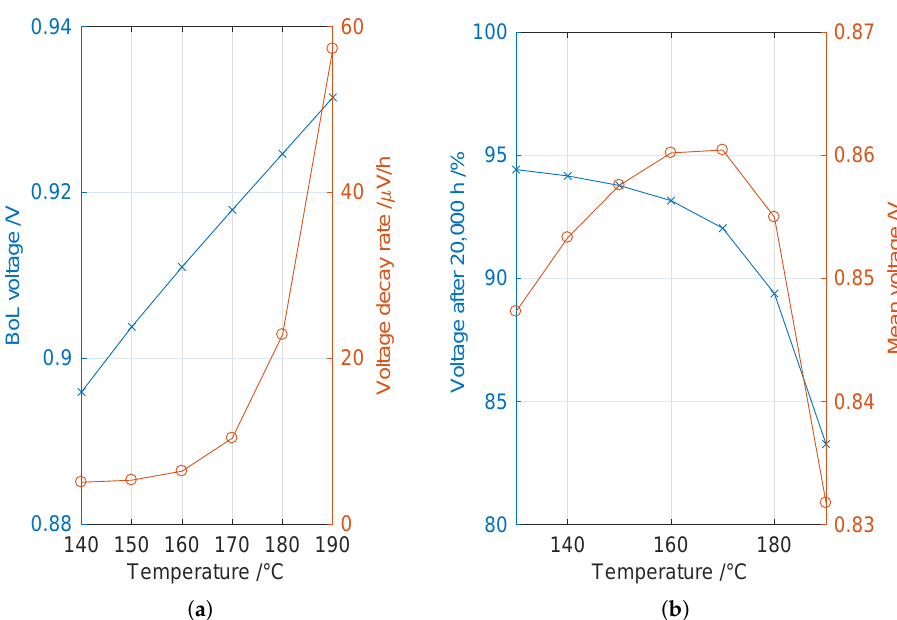
Figure 9. Voltage decay rates vs. temperature. ( a ) BoL voltage and decay rates as a function of temperature. ( b ) Cell voltage after 20,000 h and mean operating voltage as a function of